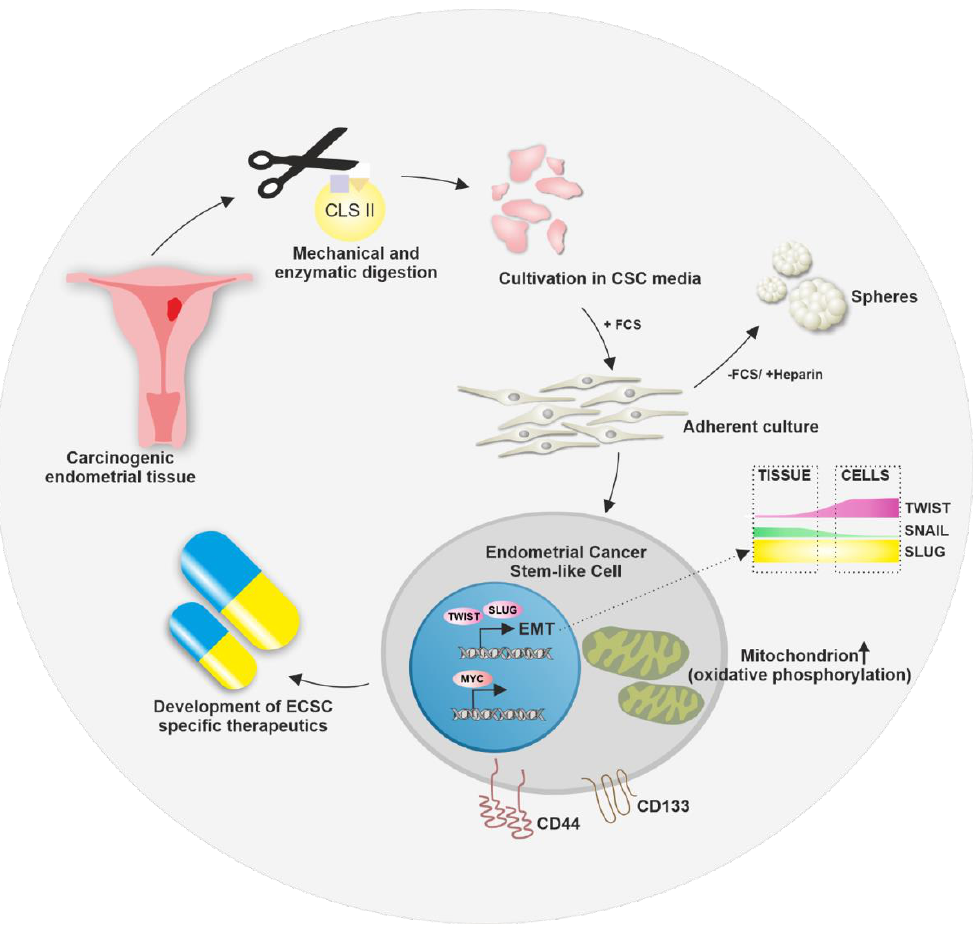
Figure 8. Establishment of endometrial cancer stem-like cells as new in vitro models. Carcinogenic endometrial tissue was sampled, mechanically and enzymatically digested and endometrial cancer stem-like cells were isolated by cultivation in CSC media. The adherent cells show CD133/CD44 co- expression, the expression of MYC and EMT key transcription factors TWIST and SLUG as well as mitochondrial metabolism. The novel endometrial cancer stem-like cells display a promising model for studying new cancer stem cell-specific therapeutics. CLS = collagenase; FCS = fetal calf serum; EMT = epithelial-to-mesenchymal